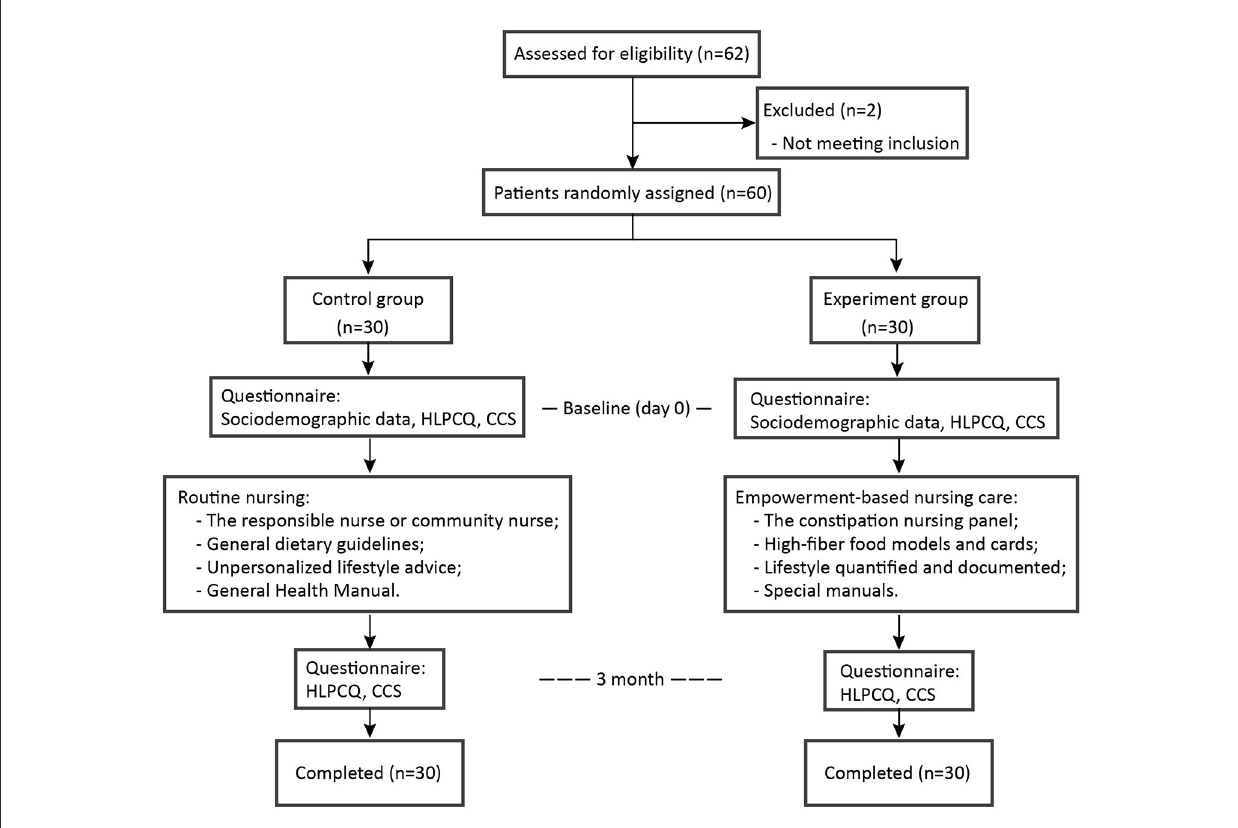
FIGURE1 Flowchart of the study.